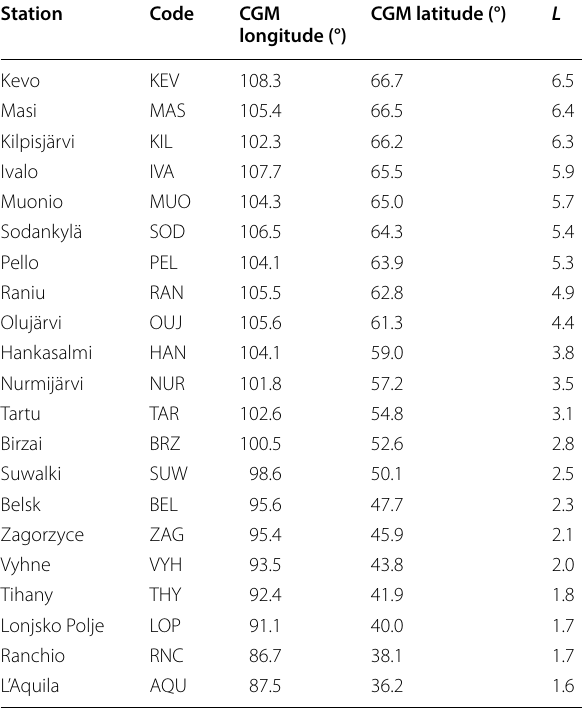
The corrected geomagnetic (CGM) coordinates and L values are evaluated at an altitude of 120 km for 1 January 2017